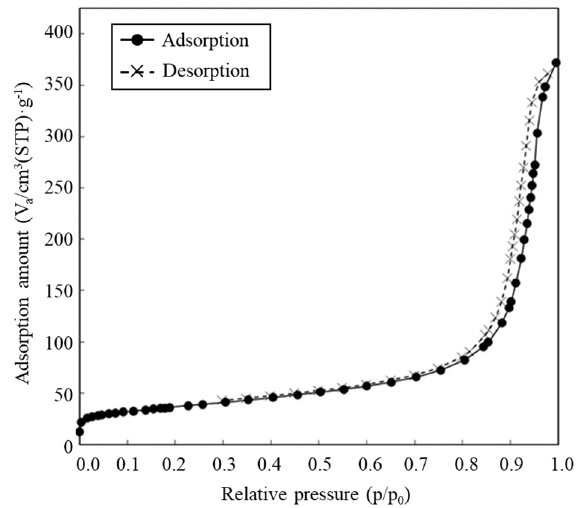
Figure 4. Adsorption-desorption isotherms. The values of adsorption and desorption were plotted against the relative pressure as circle and cross marks, respectively.